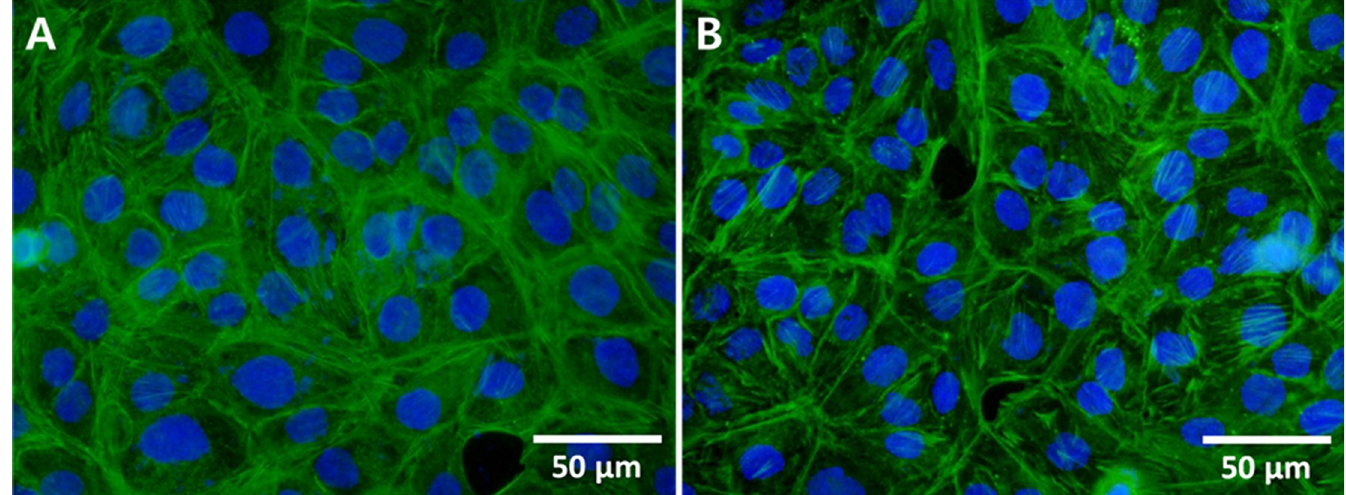
Fig 6. Immunofluorescence images of F-actin in HaCaT cells. F-actin was stained with AlexaFluor 488 conjugated phalloidin (green) and nuclei were stained with DAPI (blue). (A) Control group; (B) vibration-exposed group.